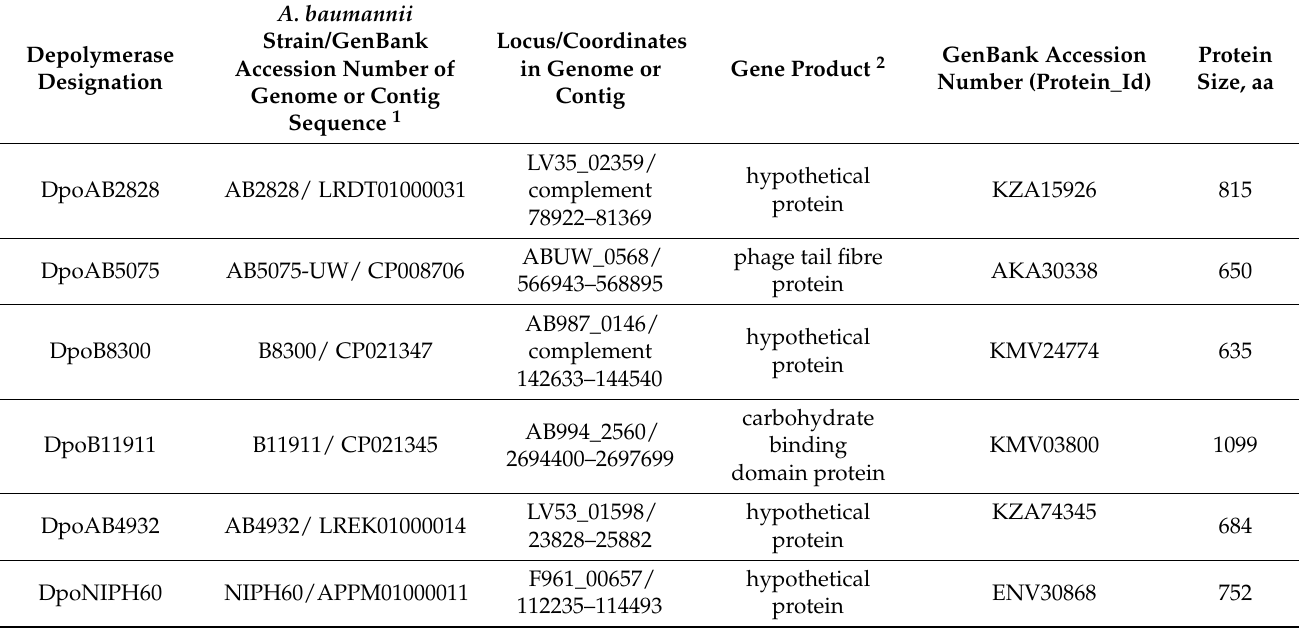
Table 1. Prophage-derived depolymerases identified in A. baumannii genomes.